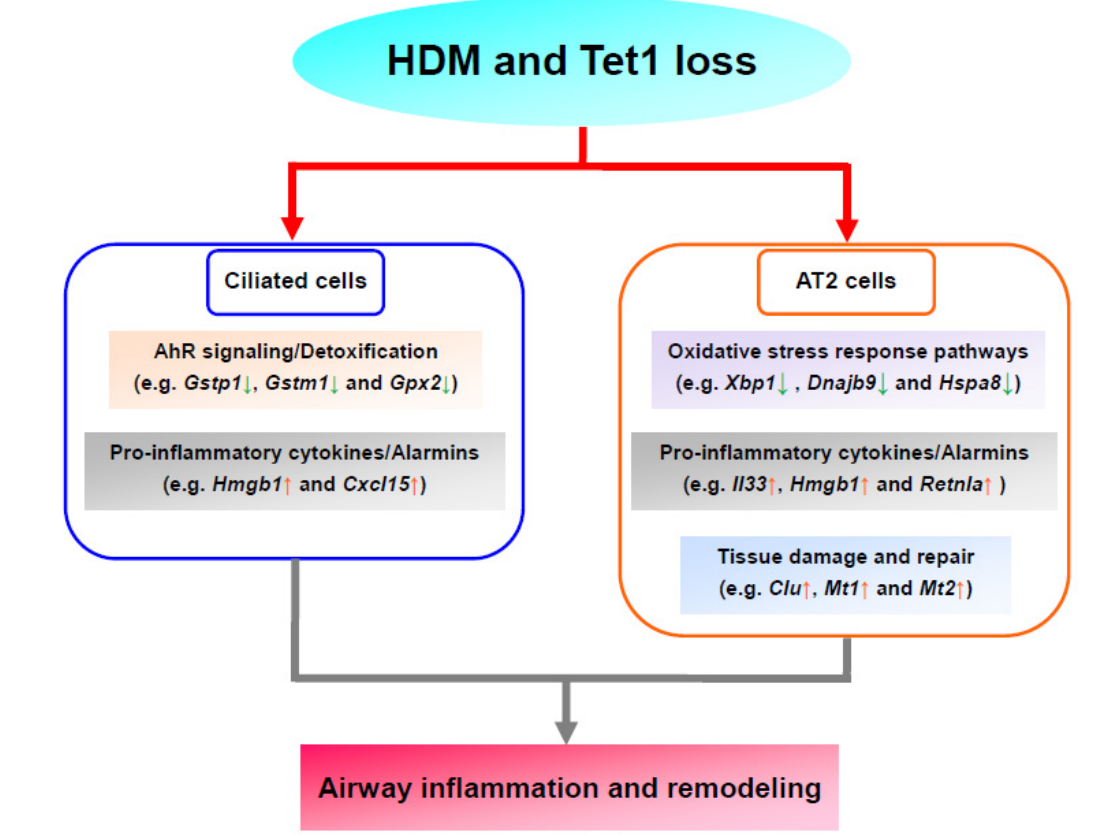
Figure 7. Proposed model based on transcriptomic analysis. Tet1 deletion downregulated (downward arrows in green) genes in AhR signaling/detoxification (ciliated cells, base line) and oxidative stress responses (AT2 cells, with HDM), and upregulated (upward arrows in red) genes in pro-inflammatory cytokines/alarmins (AT2 and ciliated cells, baseline) and tissue damage and repair (AT2 cells, with HDM). Collectively, this may aggravate HDM-induced airway inflammation and remodeling.